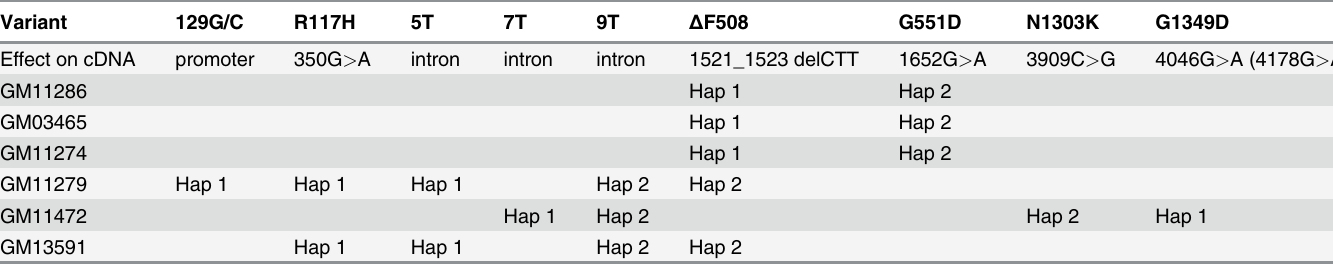
Table 1. Haplotypes formed by CFTR variants in six cystic fi brosis